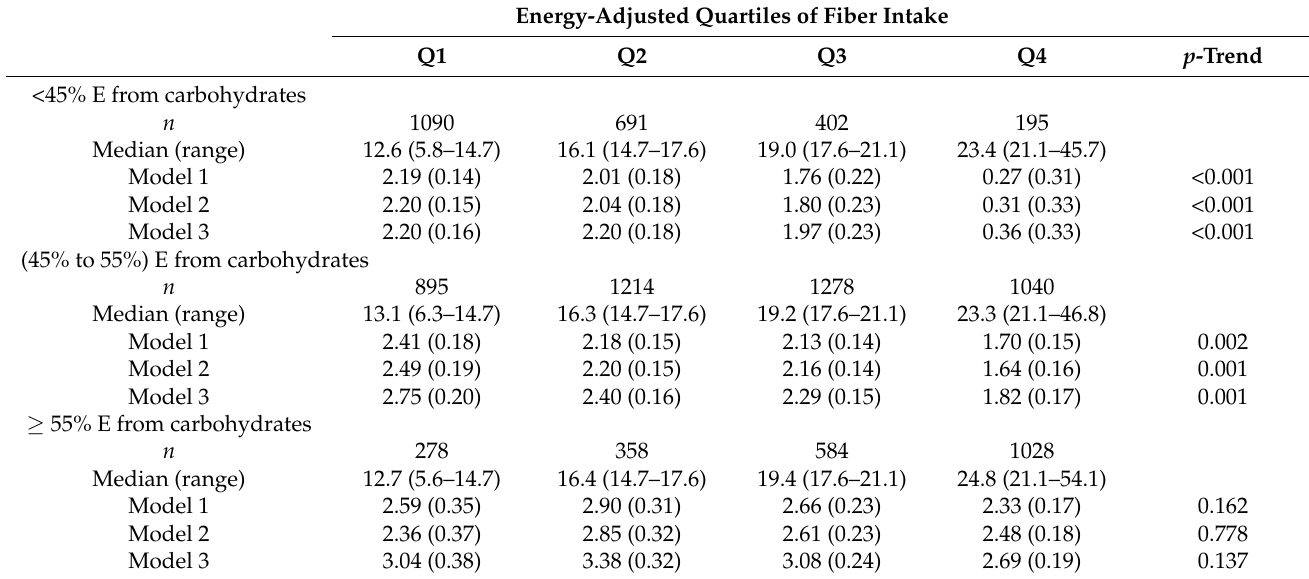
Table 7. Means (SE) of four-year change in waist circumference (cm) by quartiles of total fiber intake, stratified by totalcarbohydrate intake, in 3101 participants of the Framingham Cohort Study.